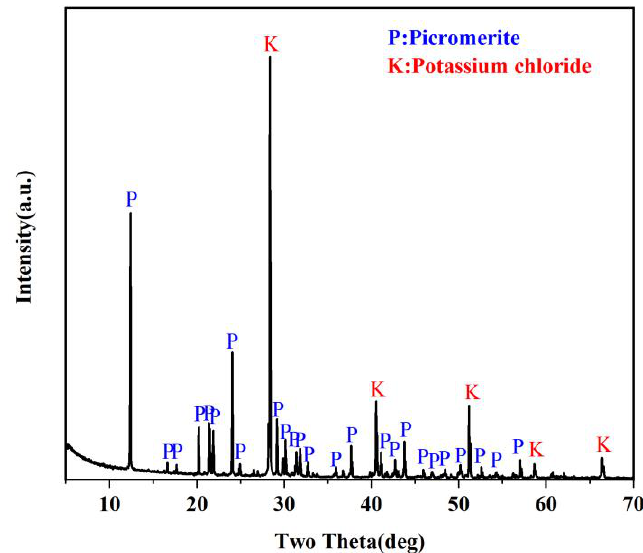
Figure 2. XRD data of MP sample.